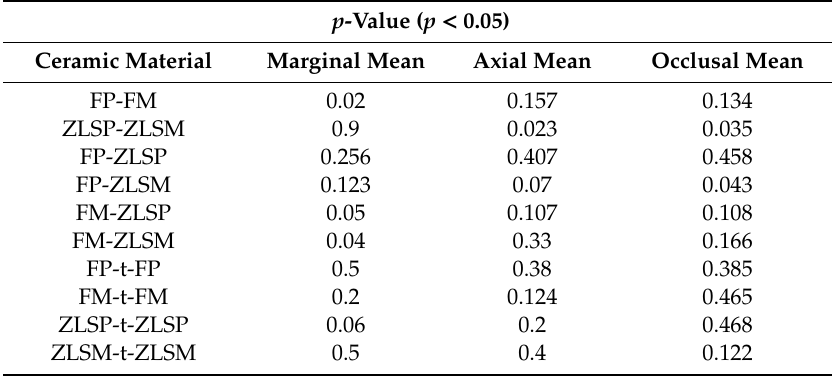
Table 7. Statistical analysis after cementing and thermocycling the samples. p -Value ( p <